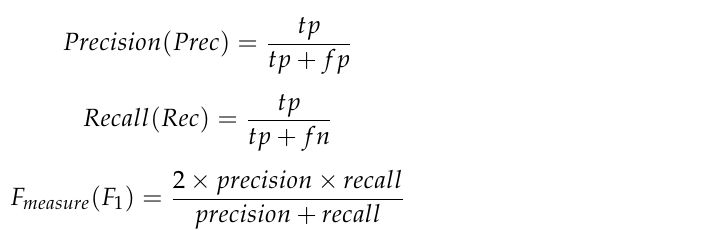
Figure 7. Localization result for test bed1 and test bed2